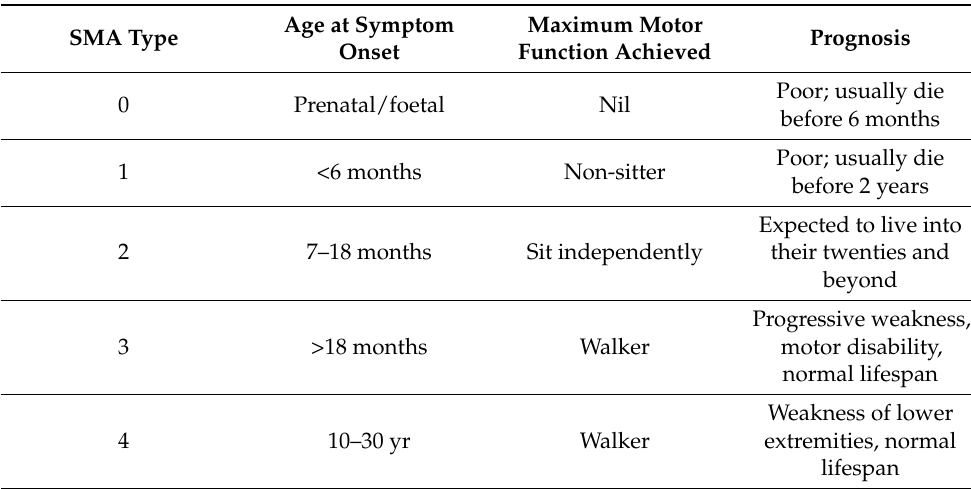
Table 1. Clinical classification of SMA based on age at symptom onset, maximum motor milestone acquired, severity of symptoms, and clinical continuum (before